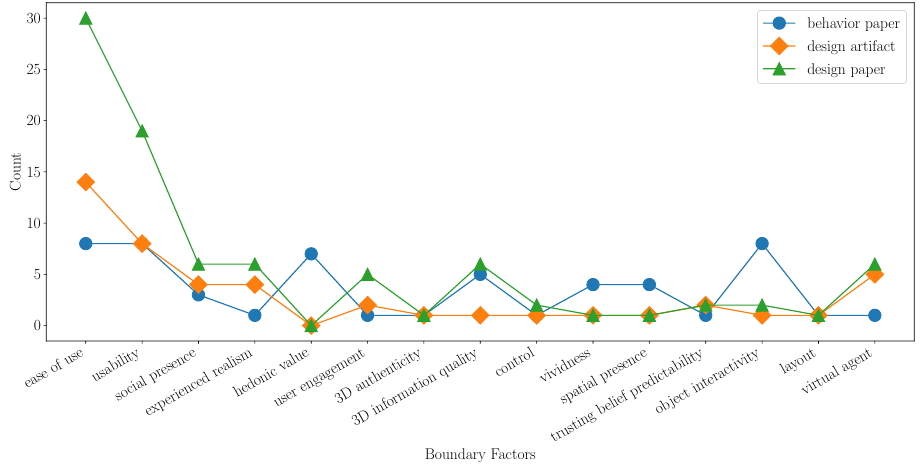
Figure 10. The occurrence of boundary factors in behavior papers, design papers, and design